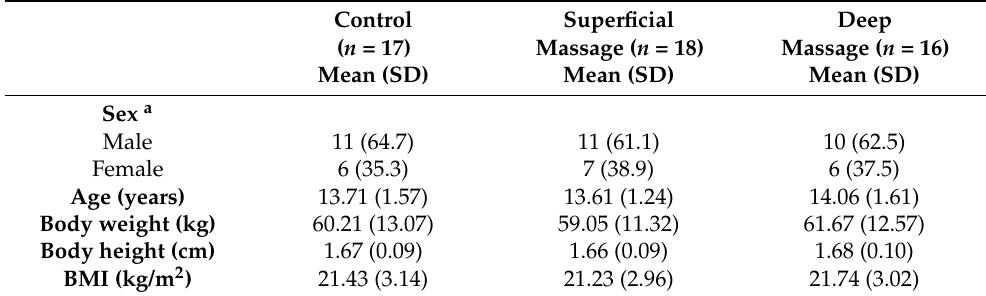
Table 1. Anthropometric characteristics at